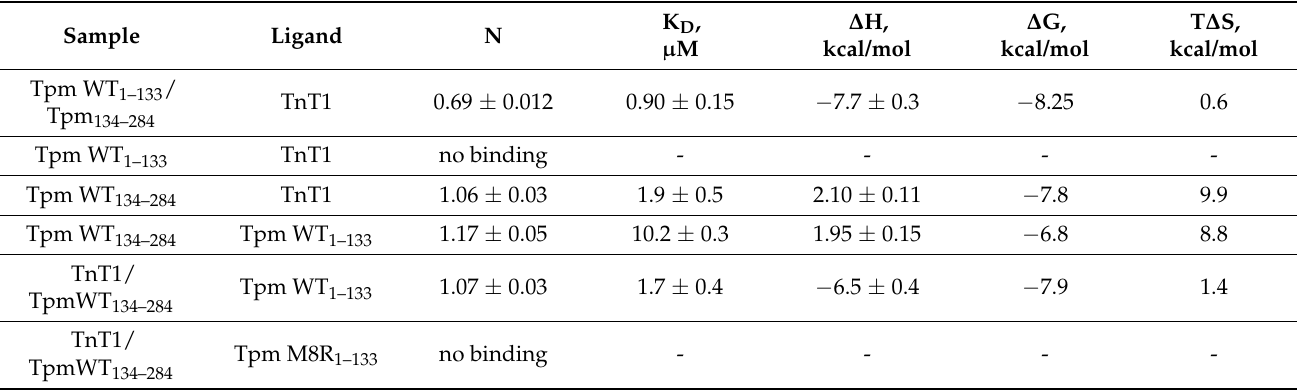
Table 6. Thermodynamic parameters of TnT1 and truncated Tpm interaction at 25 ◦ C determined by